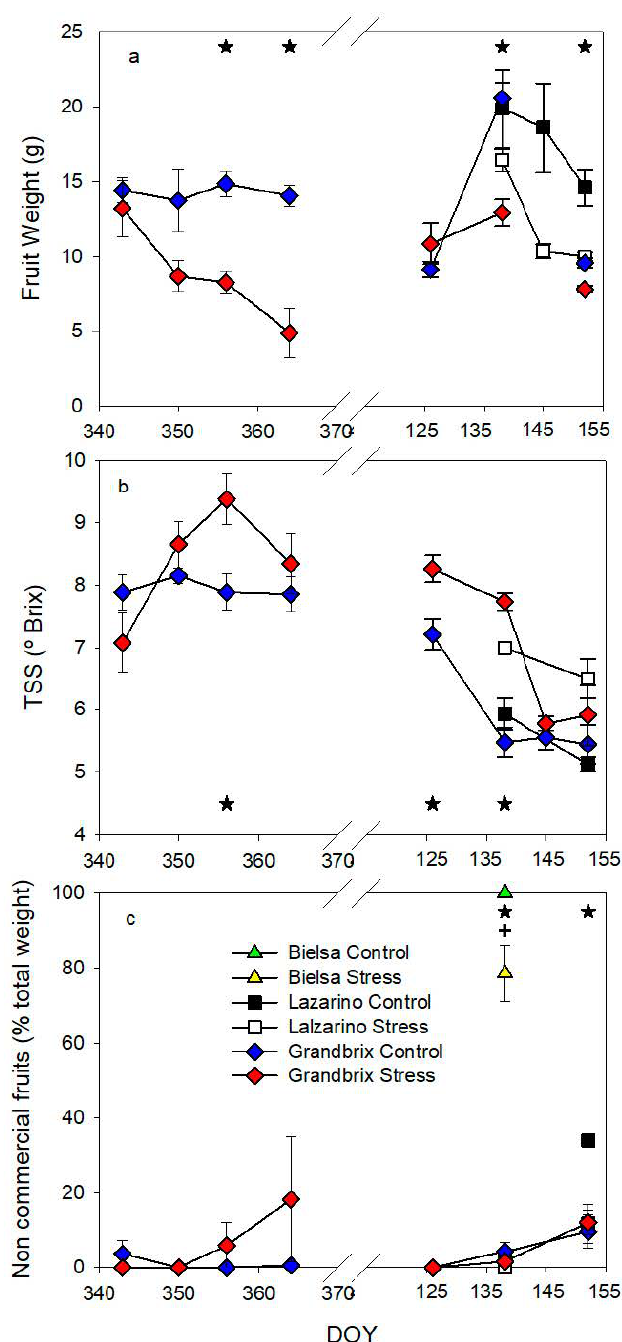
Figure 9. Pattern of fruit weight ( a ), total soluble sugars (TSS) ( b ) and noncommercial fruits ( c ) during the experiments. Each symbol is the average of 4 (autumn cycle) or 3 (spring cycle) data. Vertical bars represent the standard error. Asterisks (irrigation treatments) and crosses (cultivars) indicate the date when significant differences were found ( p < 0.05).